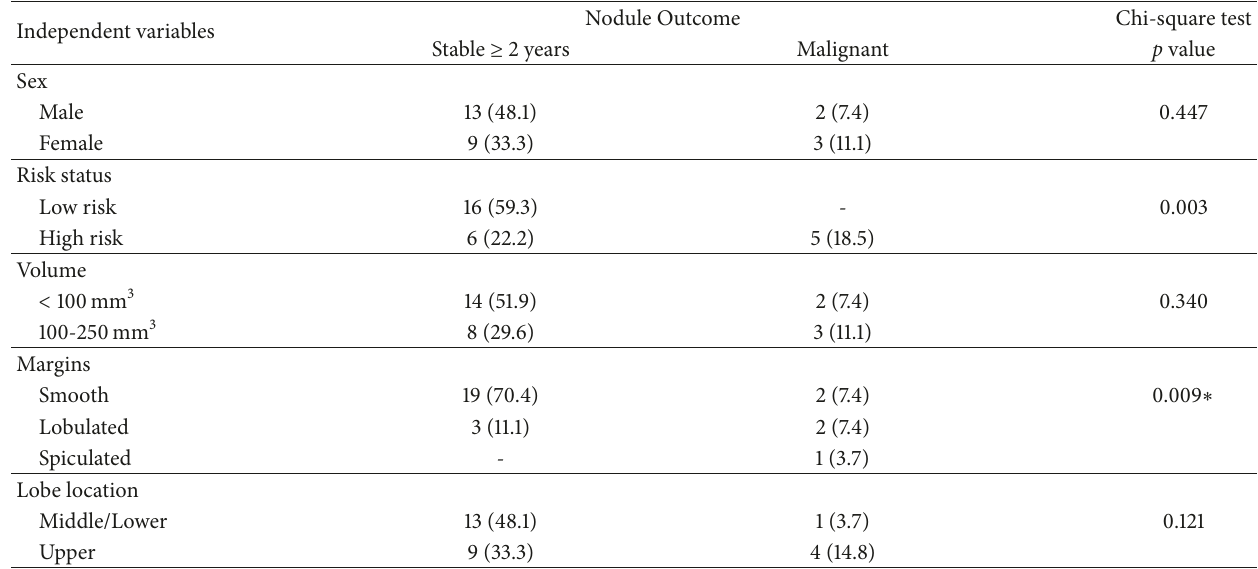
Table 5: Association between nodule outcome and independent variables (sex, risk status, volume, margins, and lobe location).